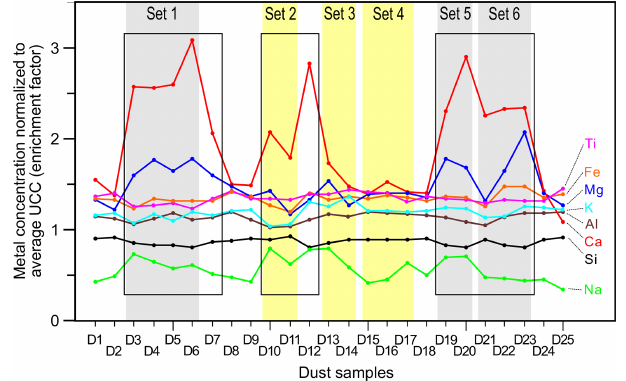
Figure 9. Time-series of variation in major element compositions of Asian dust normalized to the average values of the UCC. Dusts in the square boxes (D3–D7, D10–D12, and D19–D23) were trans- ported across the Chinese Loess Plateau and sandy deserts in north- ern China (Fig. S1). Sample collection dates are provided in Table 1. Dust sample sets 1, 5, and 6 are serial samples collected during in- dividual dust events. Dust sample sets 2–4 are samples collected at different sites during individual dust